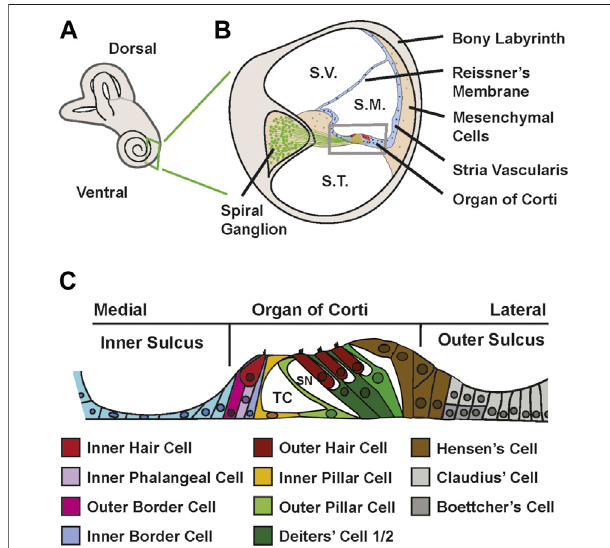
FIGURE 1 | Structure of the cochlea and organ of Corti. (A) Diagram of the mammalianinner ear.The coiled cochleais located on theventral side. (B) Schematic cross-section of the mature cochlea. Sound waves travel up the cochlear spiral through the scala vestibuli (S.V.), pass through the scala media (S.M.) which contains theorganofCorti, and thentravel back down the spiral through the scala tympani (S.T.). The scala media is a triangular-shaped structure with three morphologically distinct arms. Reissner ’ s membrane is a bilayeredstructurethatseparatesthescalamediafromthescalavestibuli.The stria vascularis, which plays a key role in maintaining ionic homeostasis in the scala media, forms the majority of the lateral wall. The fl oor of the scala media containstheorganofCortialongwiththeadjacentinnerandoutersulci(boxed area). HCs within the organ of Corti are innervated by neurons located in the spiralganglion.Theentirestructureisencasedinacapsule,thebonylabyrinth. (C) Schematic of the fl oor of the scala media. Medial and lateral sides and the three divisions of the fl oor are indicated. The medial third of the fl oor is comprised of the inner sulcus, a monolayer of epithelial cells that represents the remnants of Kolliker ’ s organ. A similar structure, the outer sulcus comprises the lateral third. In the center of the fl oor is the organ of Corti. The medial edge of the organ contains a single IHC surrounded by inner phalangeal cells and inner and outer border cells. Moving laterally, single inner andouterpillarcellscombinetoformthetunnelofCorti(TC),a fl uid fi lledspace that is presumed to contribute to structural stability. In the lateral half of the organ, three OHCs are surrounded by Deiters ’ cells which can be divided into 1 st /2 nd row and 3 rd row cells at P1 based on gene expression. The Deiters ’ cells create the spaces of Neul (SN) between the outer hair cells. . At the extreme lateral edge of the organ are Hensen ’ s cells which probably provide structural stability to the